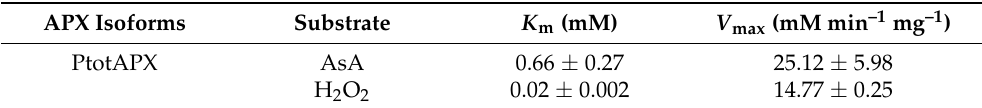
Table 1. Enzymatic properties of recombinant